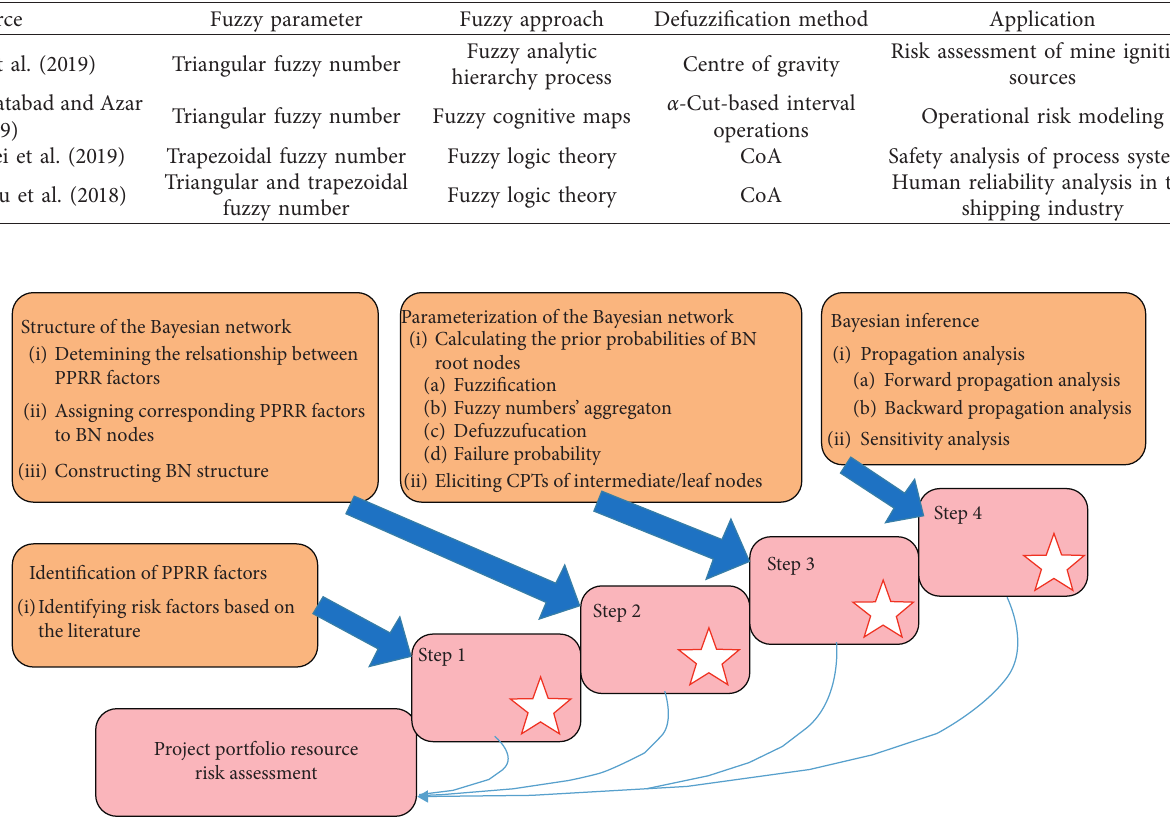
Table 1: Related work on the fuzzy Bayesian network.